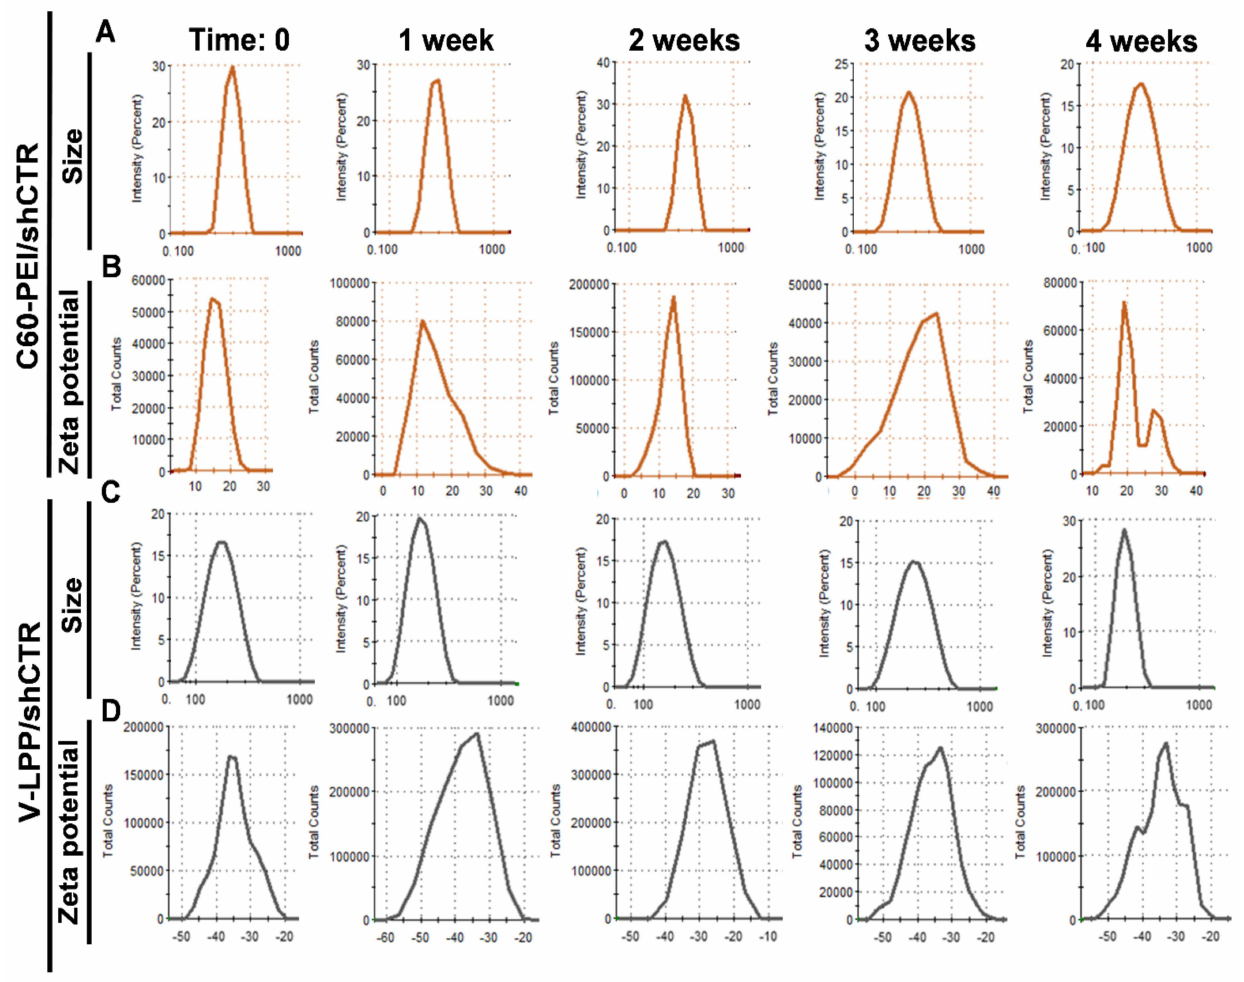
Figure 2. Particle size intensity distribution of C60-PEI/shCTR ( A ) and V-LPP/shCTR ( C ) as mea- sured by dynamic light scattering and Zeta potential distribution of C60-PEI/shCTR ( B ) and V- LPP/shCTR ( D ) measured by electrophoretic light scattering at the initial time and after storage at 4 ◦ C for up to one